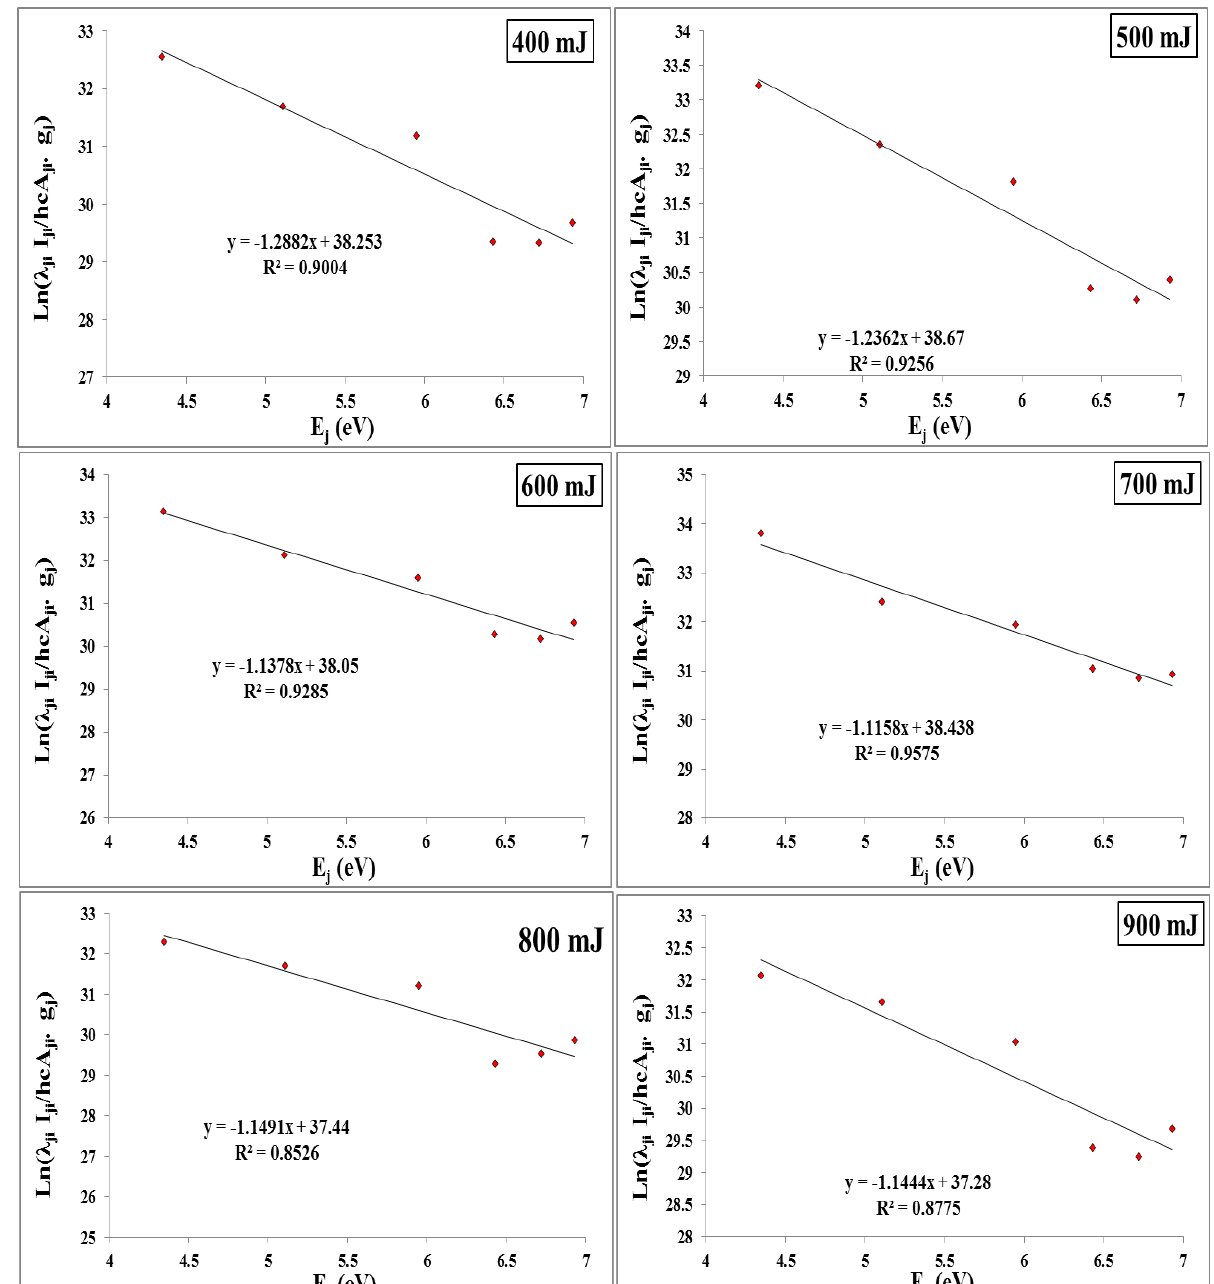
Fig.6: Boltzmann plot method for magnesium using 1064 nm laser, with different laser